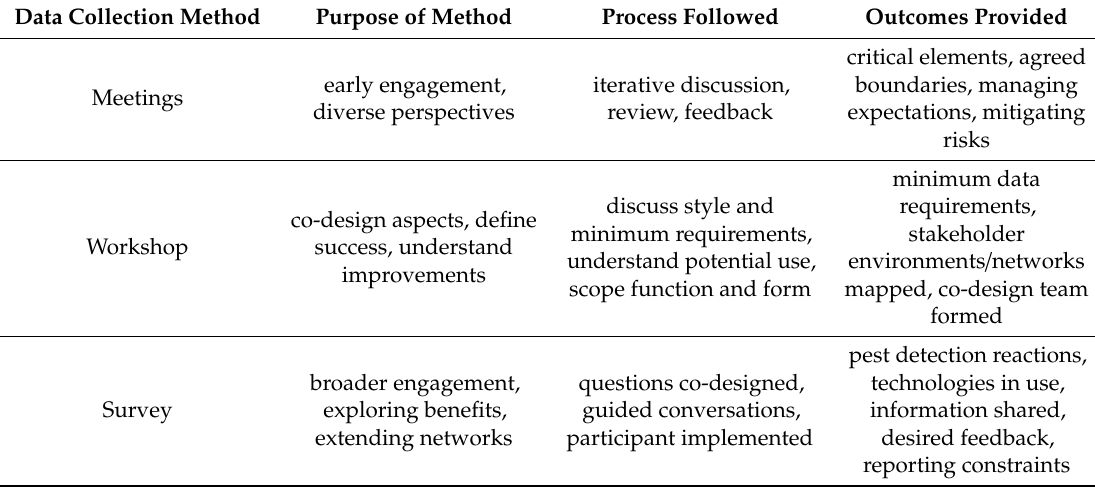
Table 1. Mixed methods of data collection according to their purpose, process and outcomes.